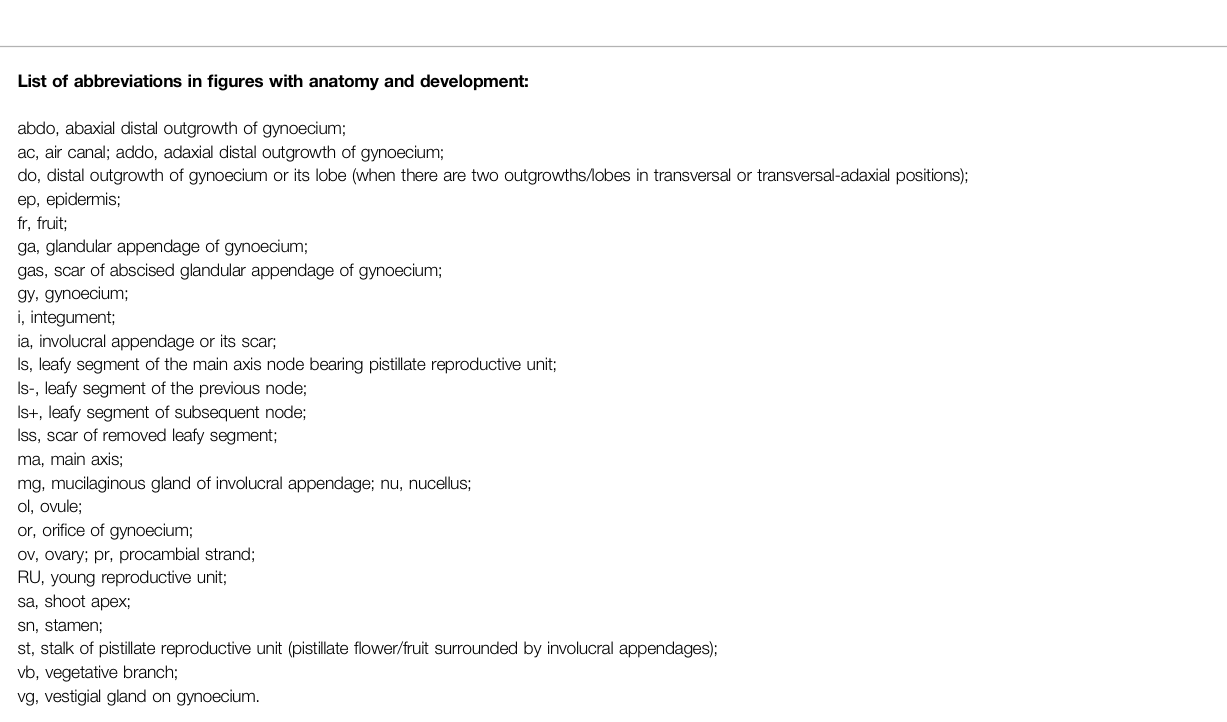
FIGURE 3 | segments of a node. (D) Abaxial view of a fl ower with two equal distal gynoecial outgrowths. The fl ower is attached to a stem node between two leafy segmentsthatareexcised.Sectionsofthis fl owerareshownin Figure7 . (E) Abaxialviewof fl owerwithinvolucralappendagesremoved.Thetwodistalappendagesare of unequal size. (F) Side view of fl ower with unequally bilobed distal appendage. Scale bars = 30 μ m in (A – C) , 300 μ m in (D – F) .